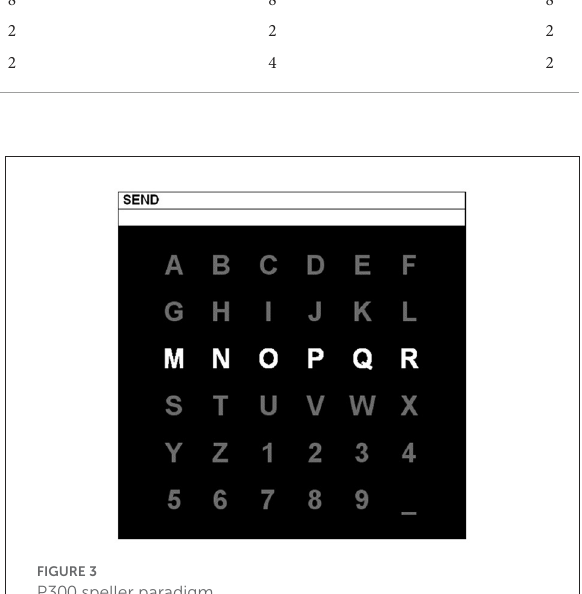
FIGURE3 P300 speller